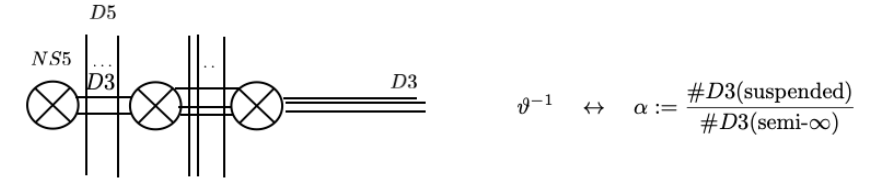
Figure 2 . The geometric ratio α corresponds to the relative number of D3 branes that are either semi-infinite or suspended between the D5 branes in the brane configuration realizing the IIB embedding with a gravitating AdS